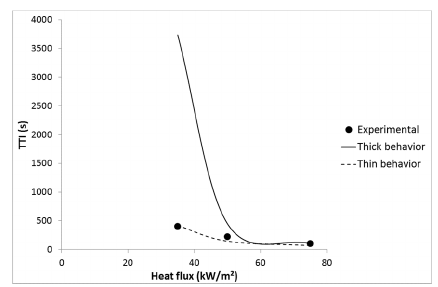
Figure 14. Experimental and predicted TTI versus heat flux for LDPE coated with 5A20 ‐ 100 coating.